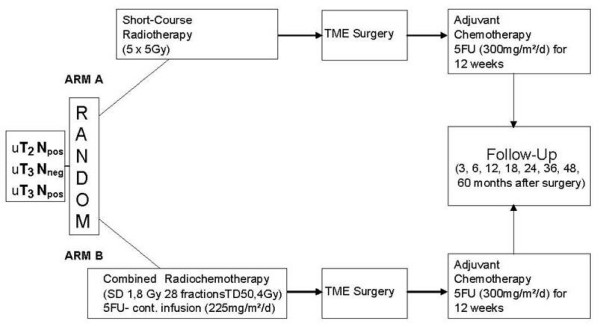
Treatment algorithm.